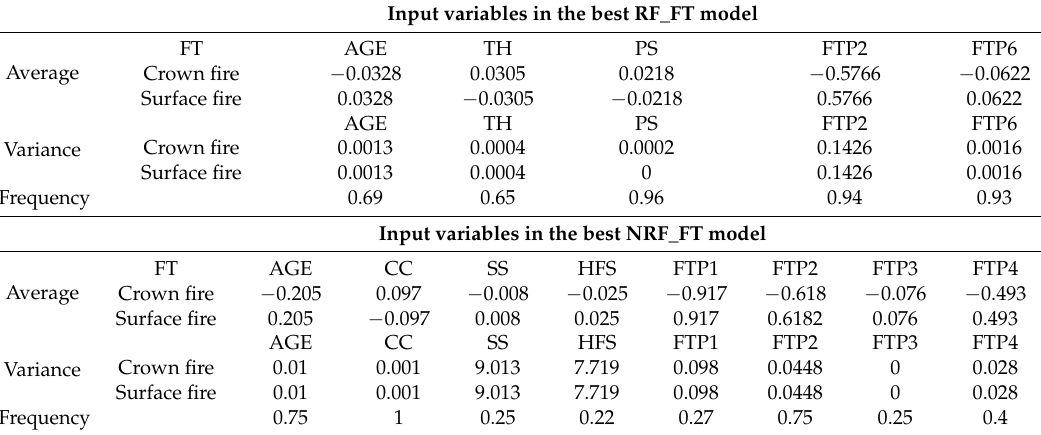
Table 5. Sensitivity analysis of the best models for the classification of Fire Type within reforested and not reforested stands (all